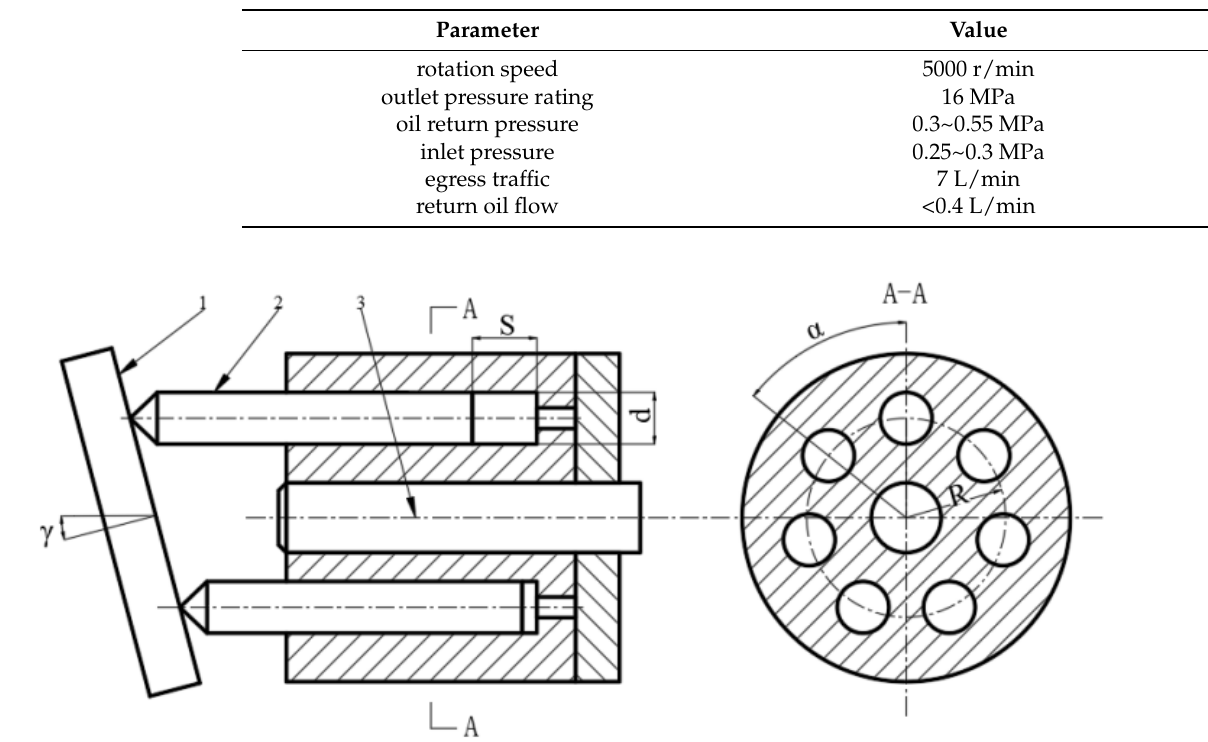
Table 1. Parameters of the Plunger Pump.